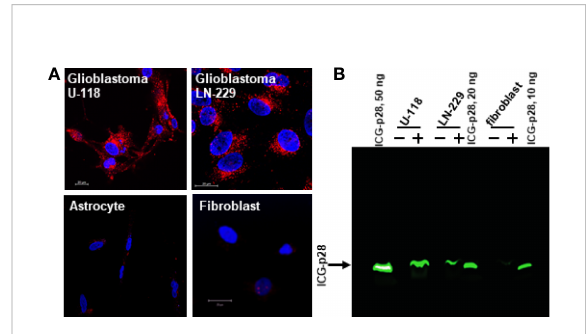
FIGURE 1 Preferential penetration of p28 into human glioblastoma cells. (A) , human GBM cell lines (U-118 and LN-229) and astrocyte and fi broblast were cultured with Alexa Fluor 568 – labeled p28 at 37°C for 2 hr, and images were recorded by confocal microscopy. Red, Alexa Fluor 568 – labelled p28; blue, DAPI (nucleus). (B) , Human GBM (LN-229 and U-118) and fi broblast were treated with ICG- p28 for 2 hr. Lysates (20 µg/lane) were separated by 10% Native PAGE and ICG-p28 was imaged by the Odyssey imaging system with an 800nm channel. Positive control: 10, 20, and 50 ng/lane of pure ICG-p28. +: ICG-p28 treated cell lysate. -: untreated cell